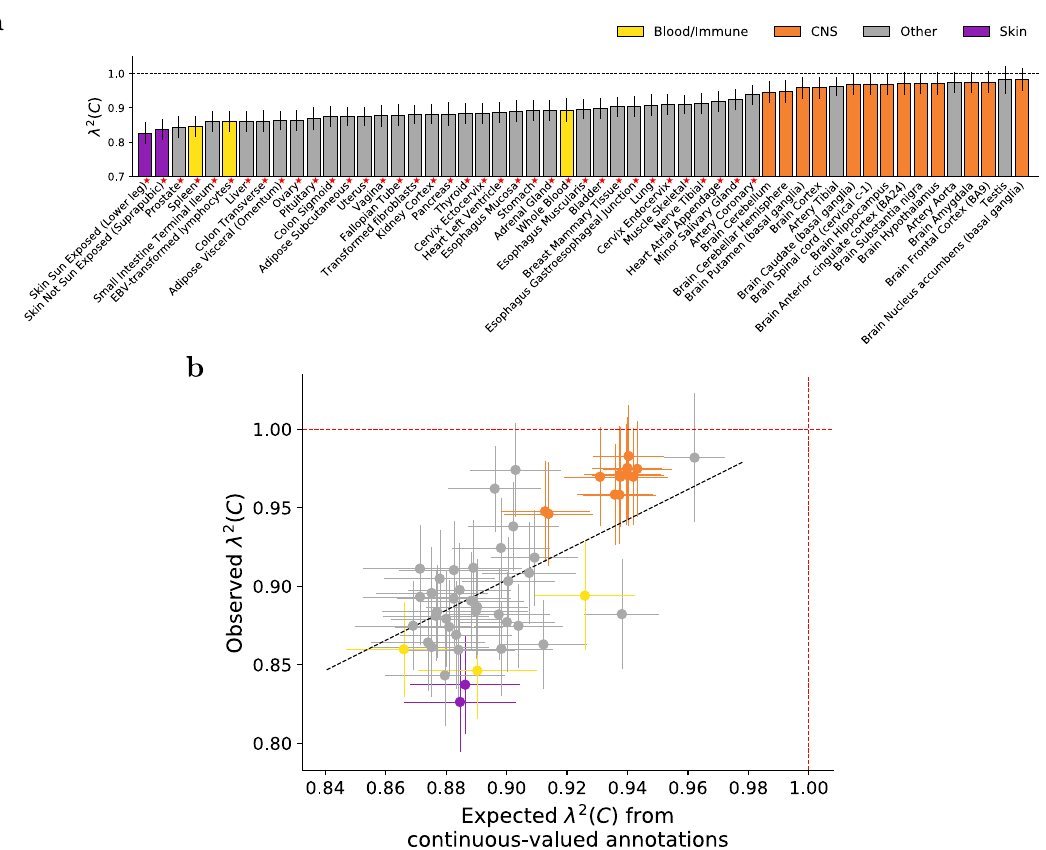
Fig. 4 S-LDXR results for 53 speci fi cally expressed gene (SEG) annotations across 31 diseases and complex traits. a We report estimates of the enrichment/depletion of squared trans-ethnic genetic correlation ( λ 2 ( C )) for each SEG annotation (sorted by λ 2 ( C )). Results are meta-analyzed across 31 diseases and complex traits. Error bars denote ± 1.96 × standard error. P -values are obtained from the standard normal distribution. Red stars ( ⋆ ) denote two-tailed p < 0.05/53. Numerical results are reported in Supplementary Data 21. b We report observed λ 2 ( C ) vs. expected λ 2 ( C ) based on 8 continuous- valued annotations, for each SEG annotation. Results are meta-analyzed across 31 diseases and complex traits. Error bars denote ± 1.96 × standard error of the meta-analyzed λ 2 ( C ). Annotations are color-coded as in ( a ). The dashed black line (slope = 0.96) denotes a regression of observed λ ( C ) − 1 vs. expected λ ( C ) − 1 with intercept constrained to 0. Numerical results and population-speci fi c heritability enrichment estimates are reported in Supplementary Data